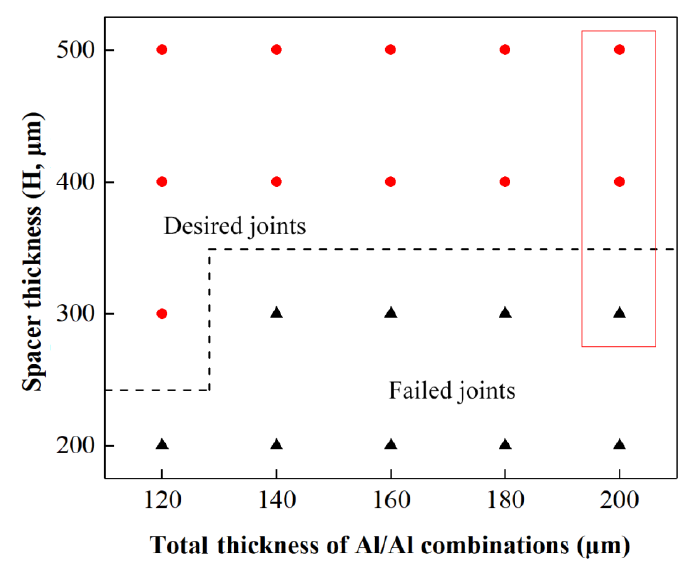
Figure 17. Process window of total thickness with H for Al/Al combinations.